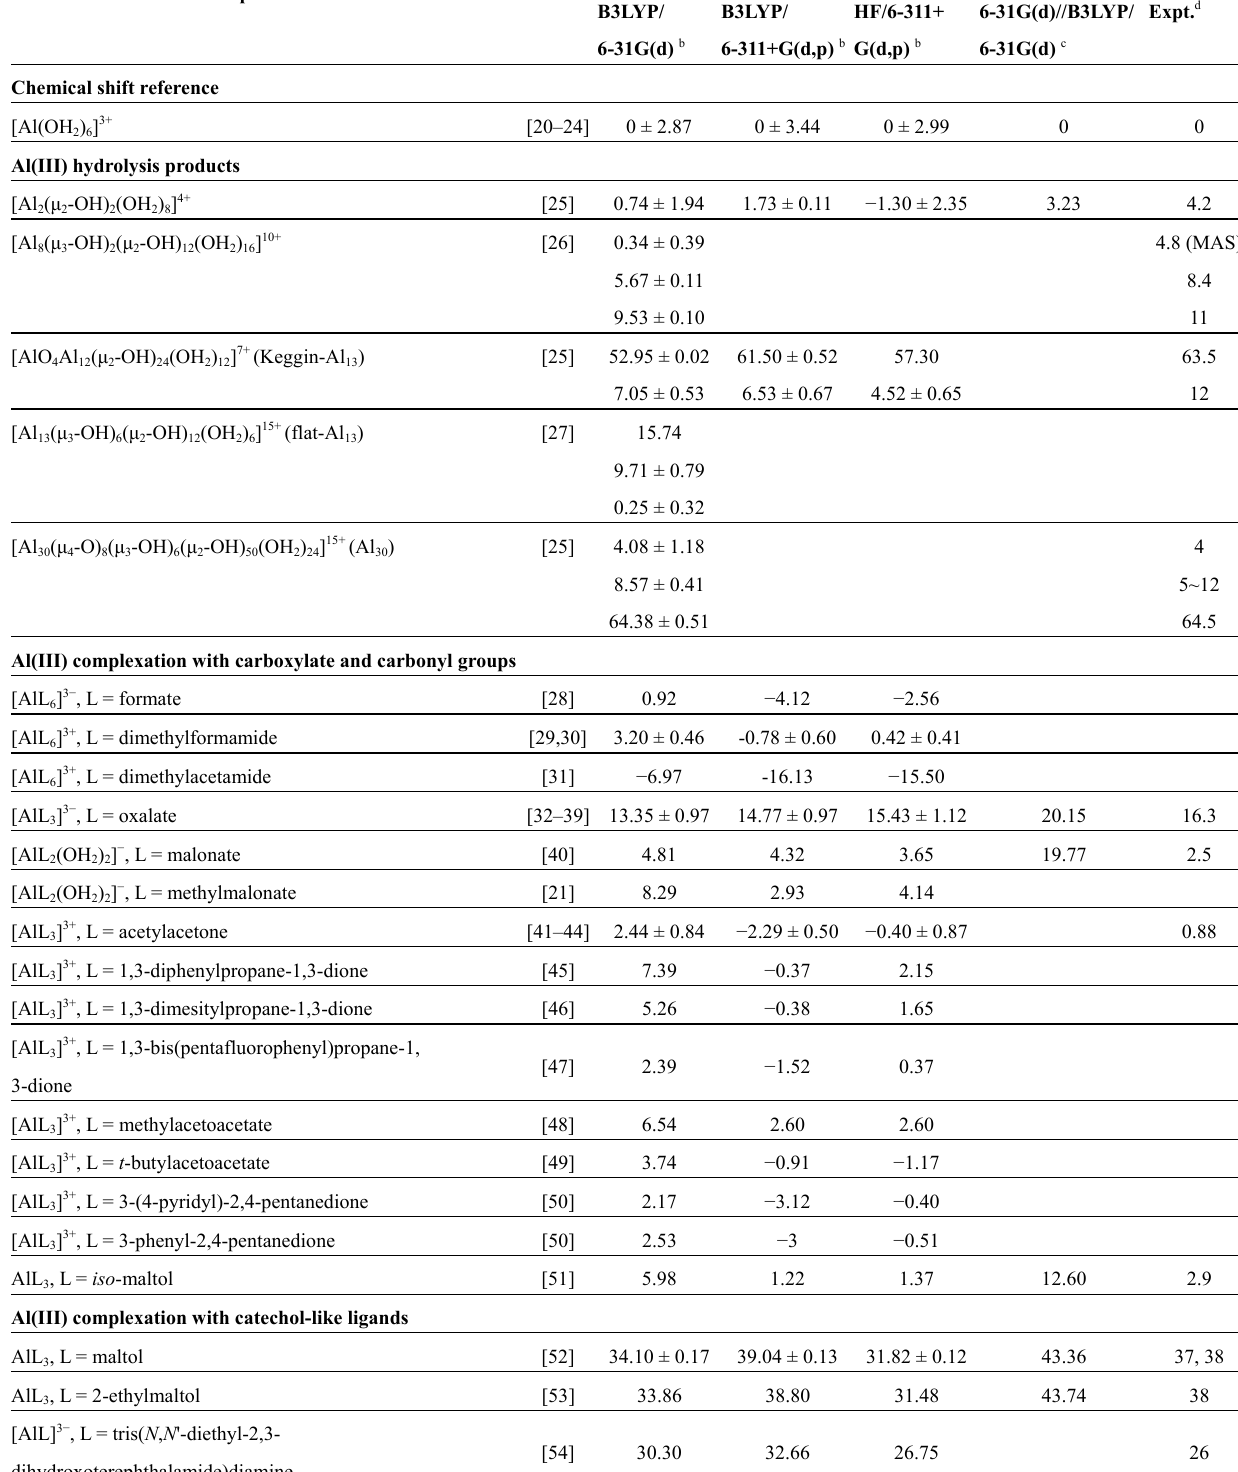
Table 1. Comparison between the calculated and experimental 27 Al chemical shifts. Species a Refs.